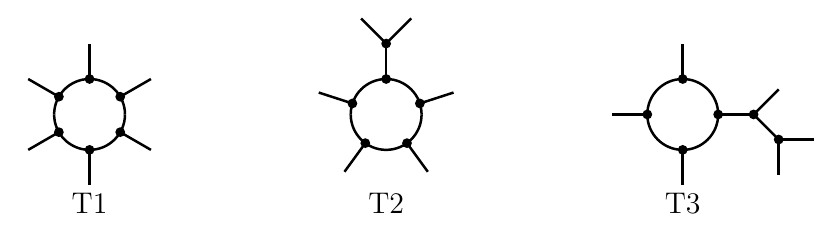
Figure 3 . Generating topologies, starting from the simplest topology, containing only 3-point vertices with all 6 particles connected to the loop, T1. Subsequent topologies are found by removing systematically particles attached to the loop and reconnecting them to ouside particles, as shown for the examples T2 and T3. See